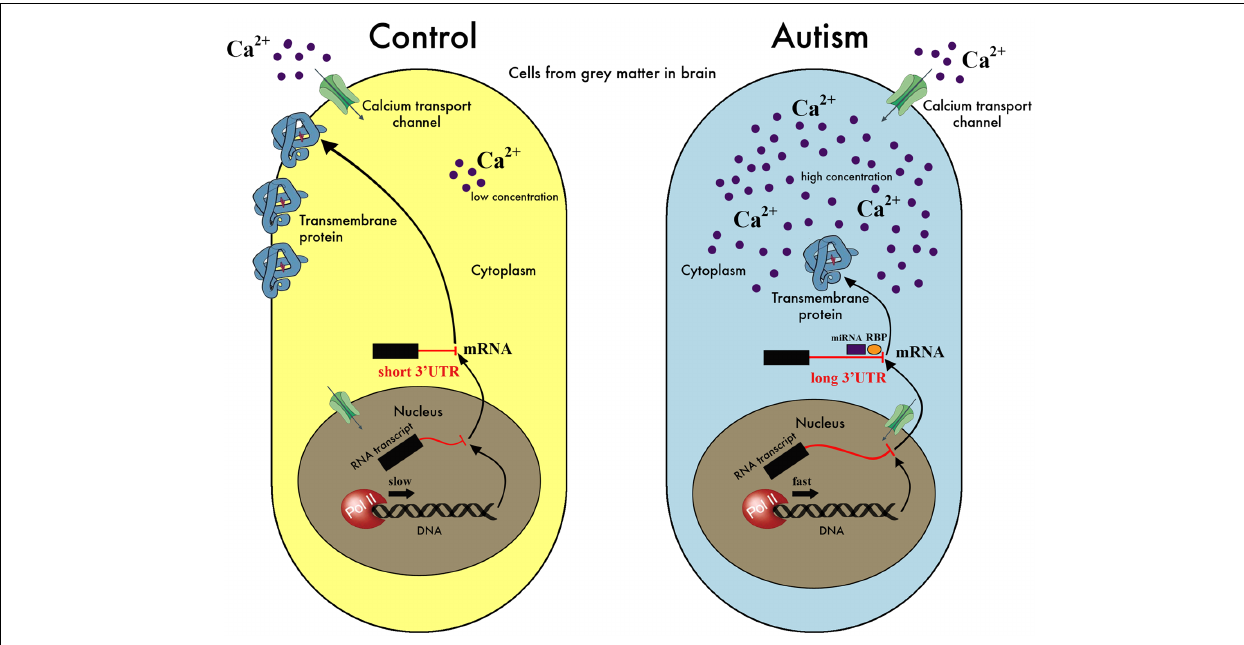
FIGURE 1 | A model for the hypothesis of APA dysregulation in the autistic brain. Our hypothesis suggests that a disruption of regulation of calcium levels in the cell affects the kinetics and pausing of Pol II, resulting in aberrant selection of poly-adenylation sites during the transcription process. In this simplified schematic, an excess of calcium in the autistic cell is signaled to the nucleus increasing the speed of Pol II and leading to preferential selection of the distal over the proximal poly-adenylation sites. This, in turn, results in the inclusion of regulatory elements in the 3 (cid:48) UTR, such as binding sites for miRNA or RNA-binding proteins (RBP), at times when their presence is undesirable. These elements affect the translation efficiency or degradation rate of the mRNA in question potentially leading to less protein product, or interfere with localization signals leading to misplaced protein. As we have no evidence for specific genes/proteins playing a major role in the hypothesis, we have deliberately avoided labeling the molecules in this cartoon of our model. It is also important to highlight that this is only one possible scenario that is compatible with our hypothesis but other possibilities exist, e.g., calcium levels may go down instead of up, the transcription process may lead to shorter rather than longer mRNAs, the amount of protein produced may or may not be affected etc. In fact, it is likely that several possibilities co-exist and are applicable to different genes, depending on the presence and levels of other factors, as well as the sequence signals integral to the mRNAs in